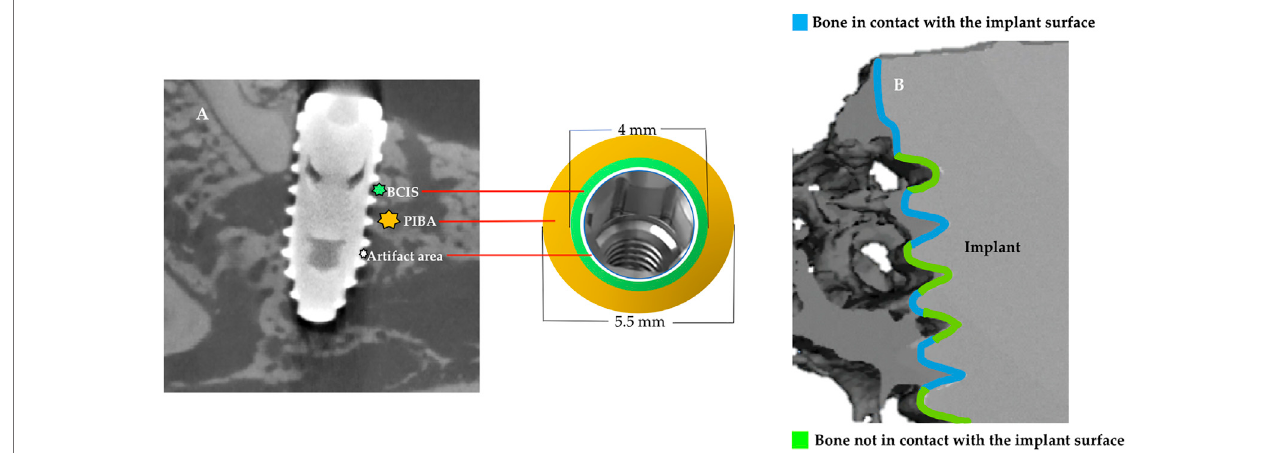
TABLE 1 | Speci fi c crestal, mid and apical trends in the experimental and control groups for BCIS (mean ± deviation). BCIS Crestal